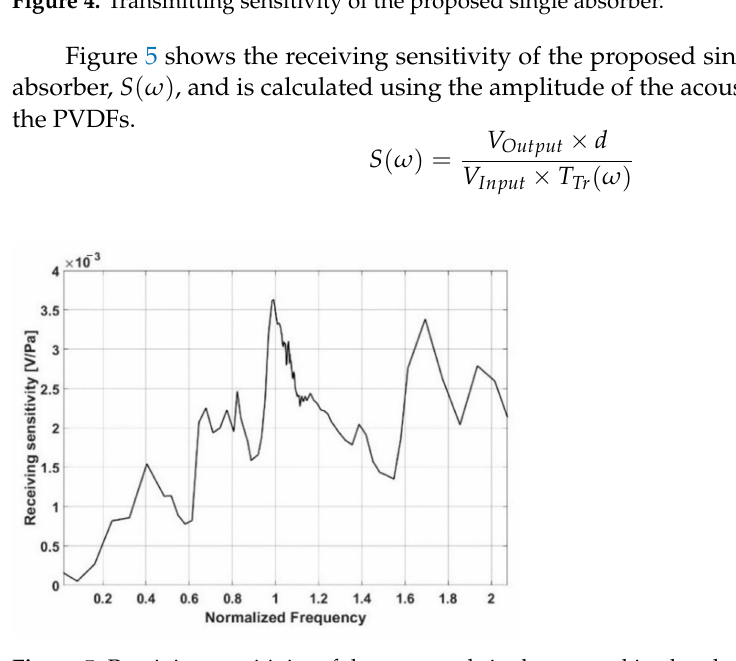
Figure 5. Receiving sensitivity of the proposed single, smart skin